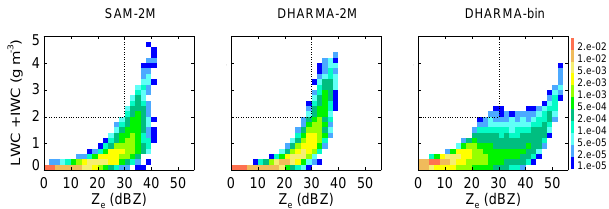
Figure 2. Joint histograms of Rayleigh-regime equivalent radar reflectivity Z e vs. total hydrometeor condensed water content LWC + IWC from the last 12h of 23 January TWP-ICE simu- lations using the System for Atmospheric Modeling (SAM) with two-moment microphysics (left panel) and the Distributed Hy- drodynamic Aerosol and Radiative Modeling for Atmospheres (DHARMA) using two-moment and bin microphysics (center and right panels, respectively) at an altitude where the mean air temper- ature is − 40 ◦ C.